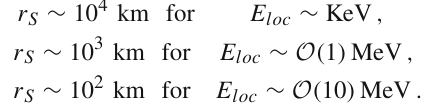
Fig. 4 Plotoftherelativechangeinthesurvivalprobabilityoftheelec- tron ( e ) flavor of neutrino due to the rotation of gravitational source in the three flavor case as a function of neutrino source location r S . Here, solid black curve, black dashed curve, and black dotted curve is for the y = 0 . 15, y = 0 . 25, and y = 0 . 35, spin parameters respectively, while